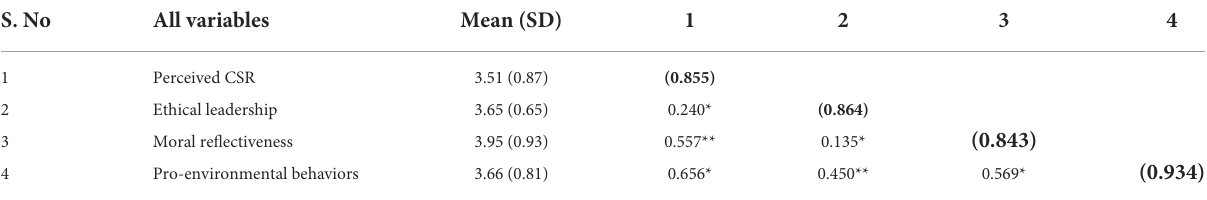
TABLE 1 Mean, standard deviation, and